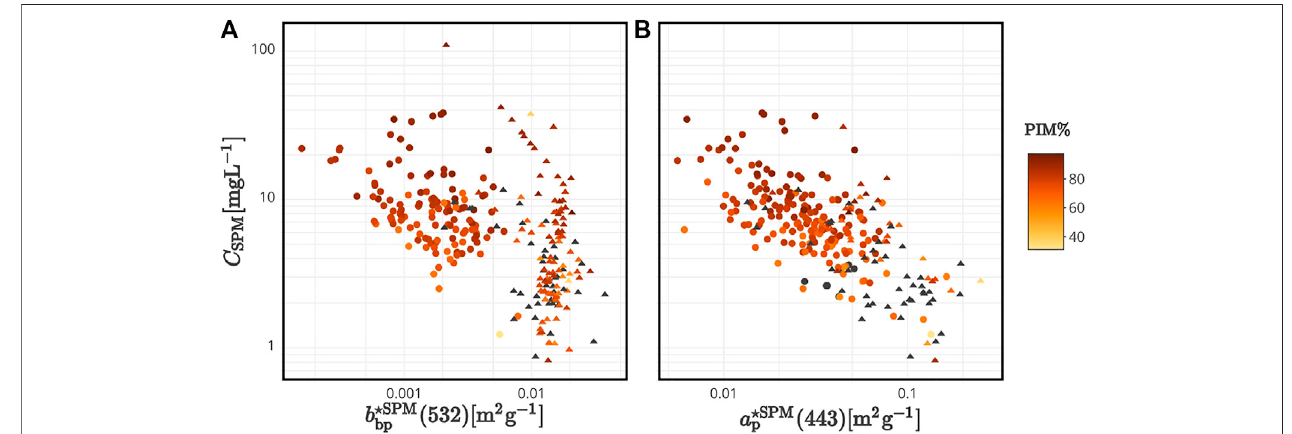
FIGURE4|(A) Mass-speci fi cparticulatebackscattering at 532 nm versus C SPM , (B) mass-speci fi cabsorption at 443 nm versus C SPM .Color corresponds to PIM fraction of total C SPM , in percent. Black points correspond to the absence of PIM data.